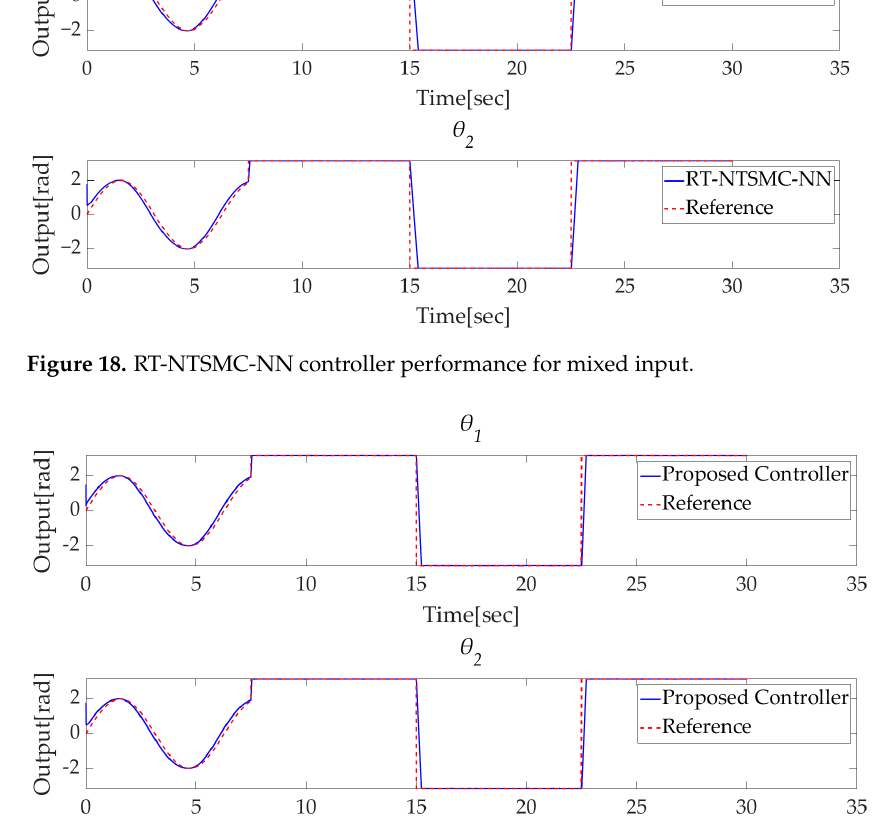
Figure 19. Proposed controller performance for mixed input.